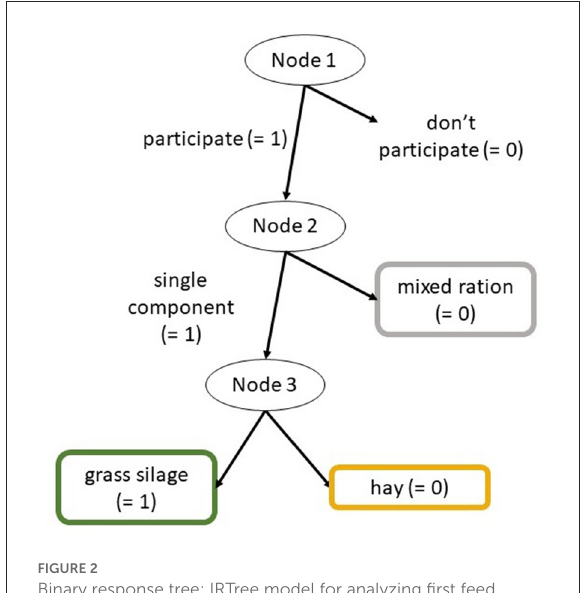
FIGURE2 Binary response tree; IRTree model for analyzing first feed